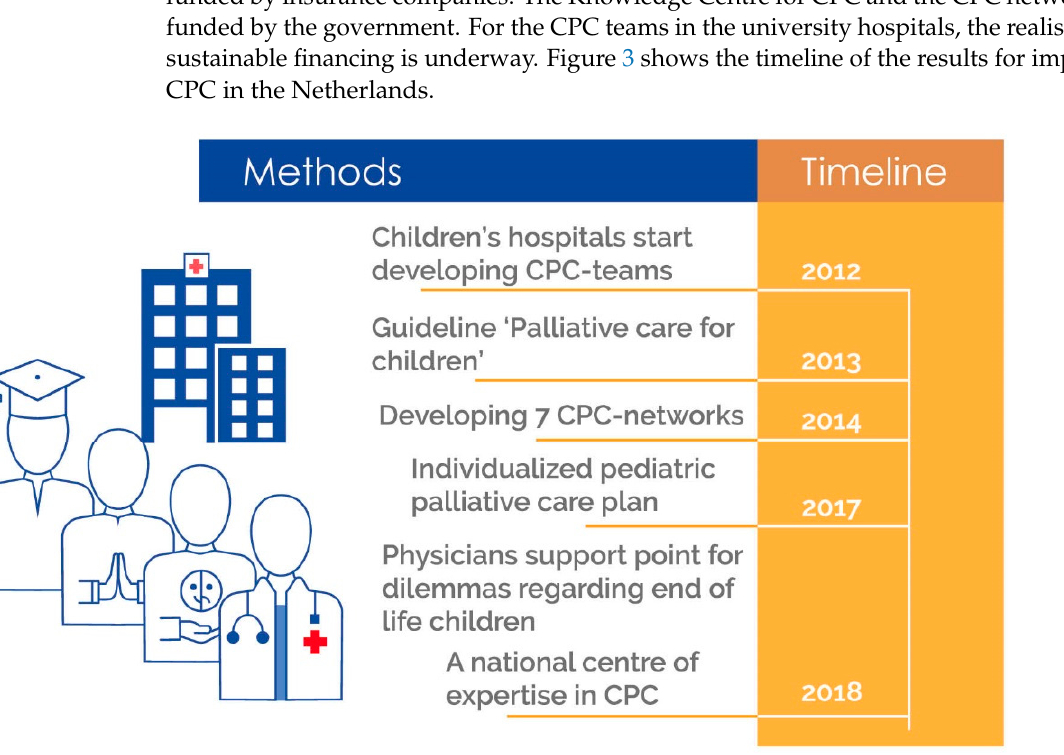
Figure 3. Timeline creation of the nationwide structure of CPC in the Netherlands.